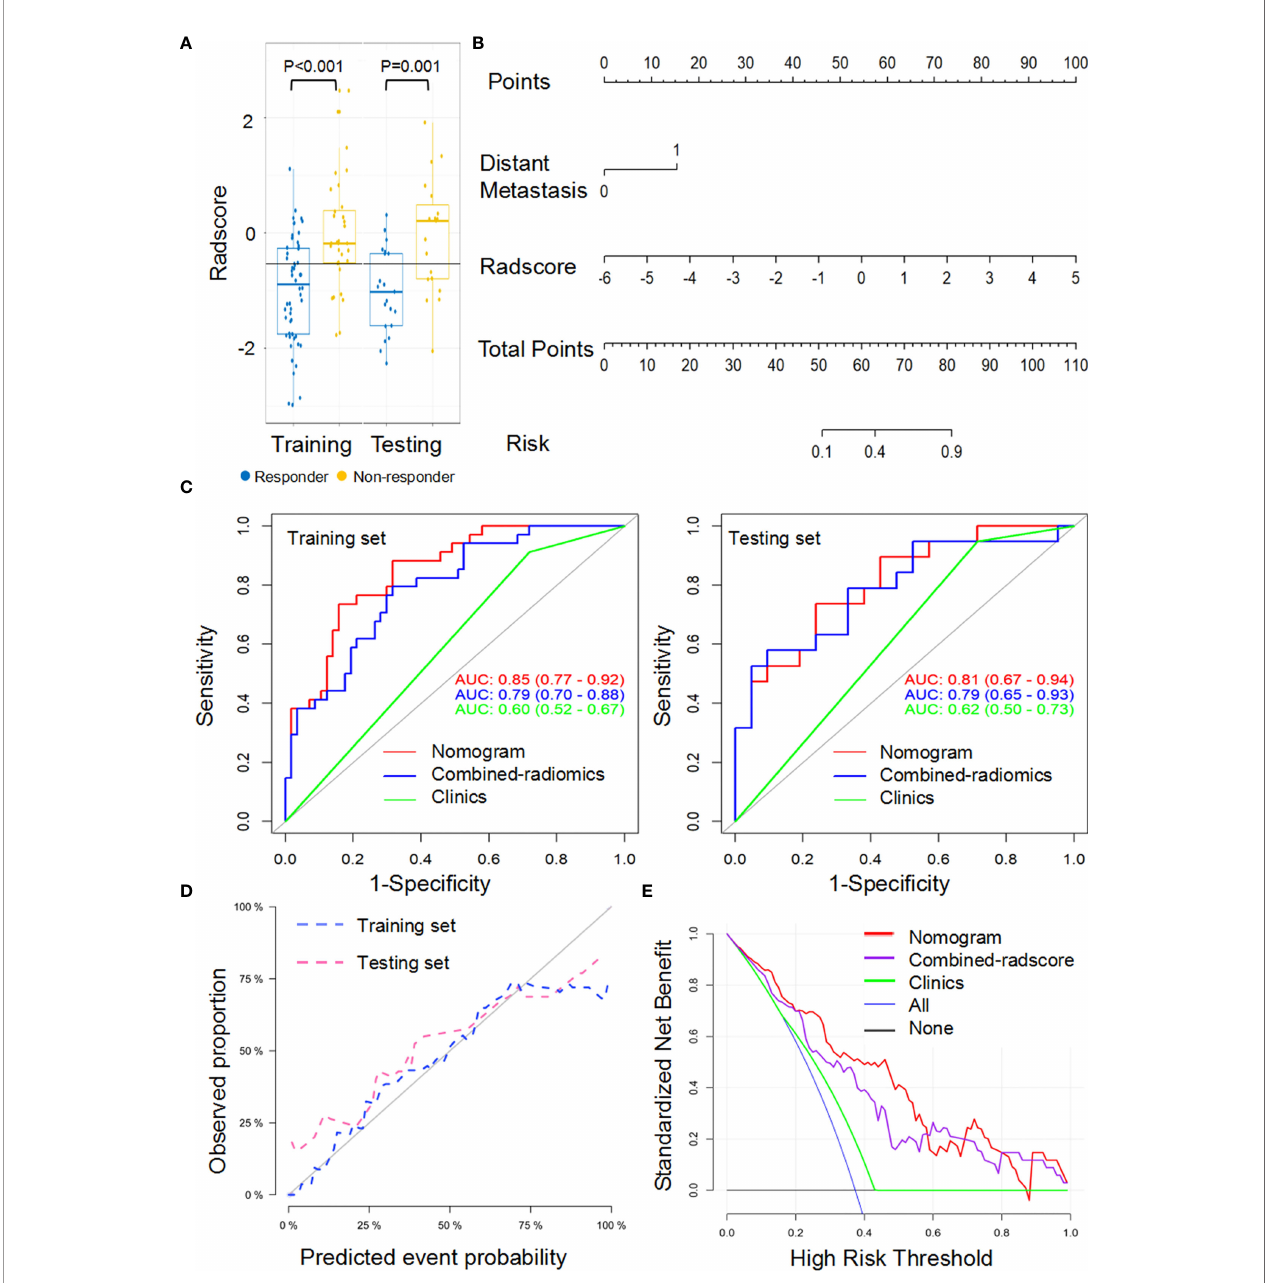
FIGURE 5 | Performance of the combined-radiomic signature from largest lesion approach in training and testing sets. (A) Box and whisker plots depict radscore comparison between responders and non-responders. (B) Radiomic nomogram developed in training set. (C) ROC curves of radiomics signatures in training and testing sets. (D) Calibration curve analysis for the nomogram in training set and testing set. (E) Decision curve analysis for the nomogram (red), radscore (purple), and clinical model (green). The y-axis indicates the net bene fi t; x-axis indicates threshold probability. The blue line represents the assumption that all patients were responders. The black line represents the hypothesis that no patients were